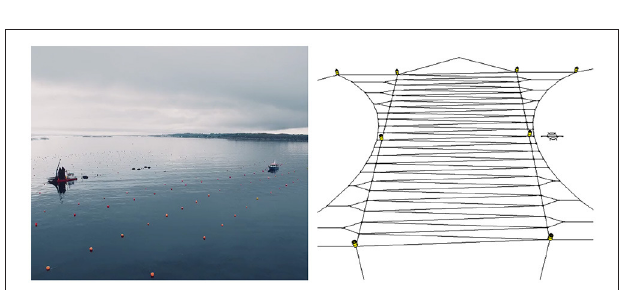
FIGURE 3 | (Left) Seaweed Energy Solutions (SES) production site (Photo: SES). (Right) Buland 10 system used by Seaweed from Norway (image from vaerlandetfiskeredskap.no). Images are reproduced with